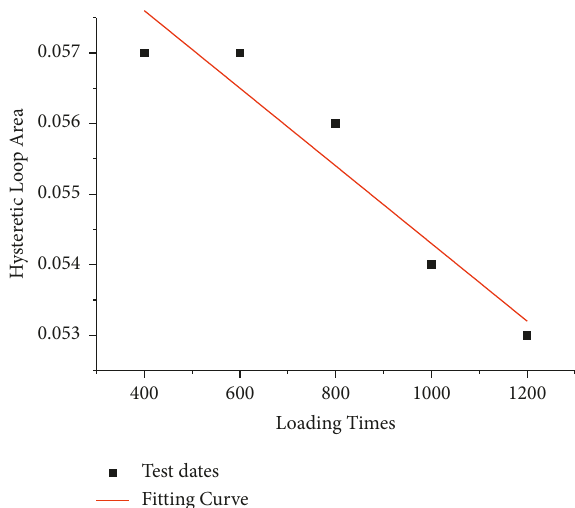
Figure 7: The relationship between hysteretic loop area and loading times.